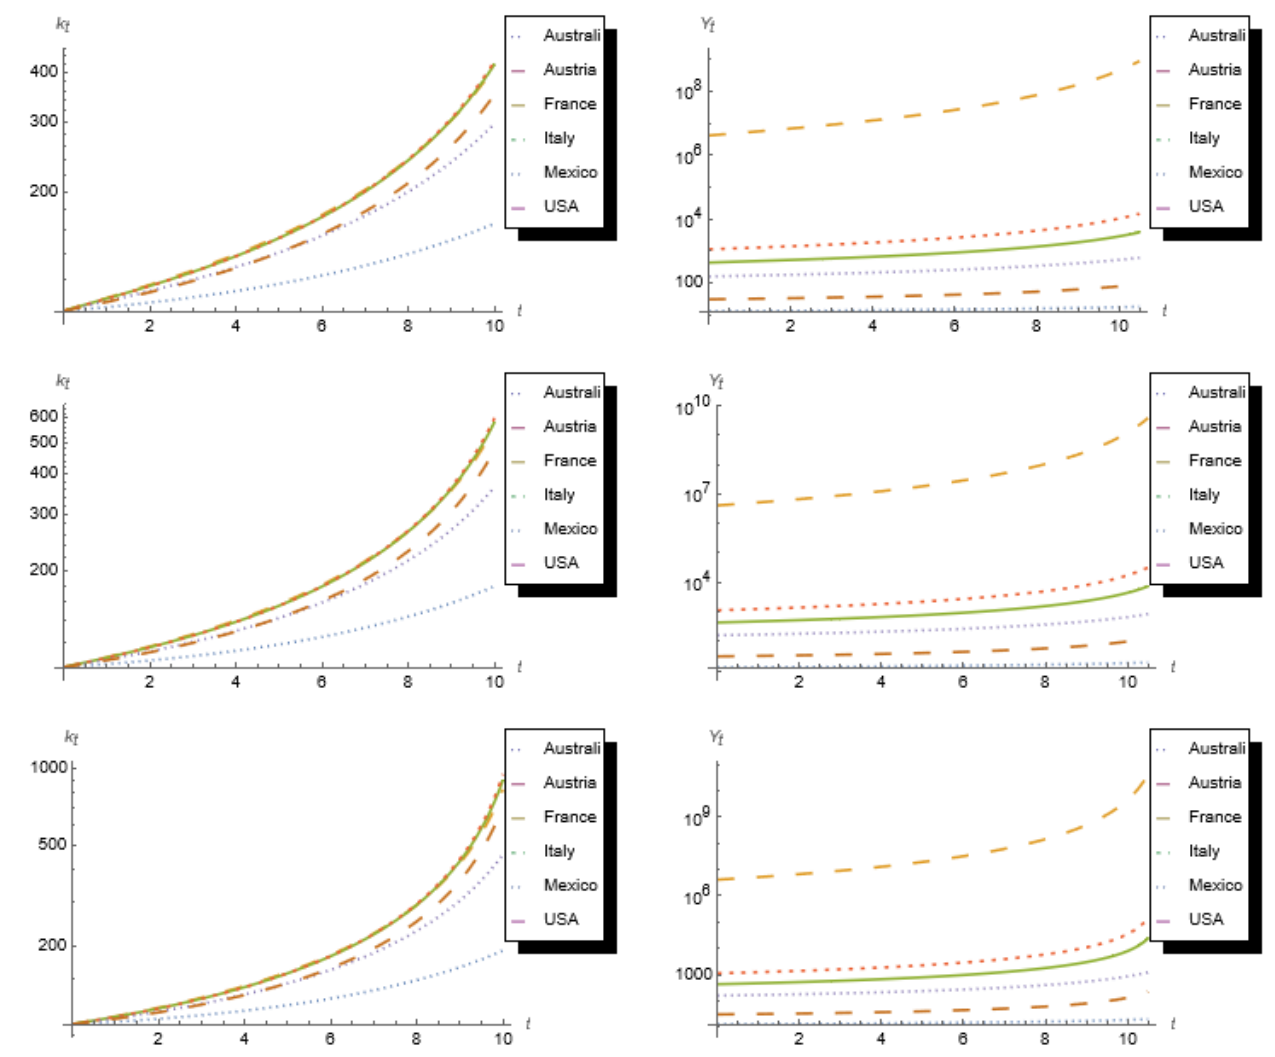
Figure 2. Value of per capita capital ( left column ) and production ( right column ) for the SM with migration of fractional order for several countries, using the parameter β = 0.9. Various values of the parameter ρ were used, namely, ρ = 0.90 ( top row ), ρ = 0.95 ( middle row ) and ρ = 0.99 ( bottom row